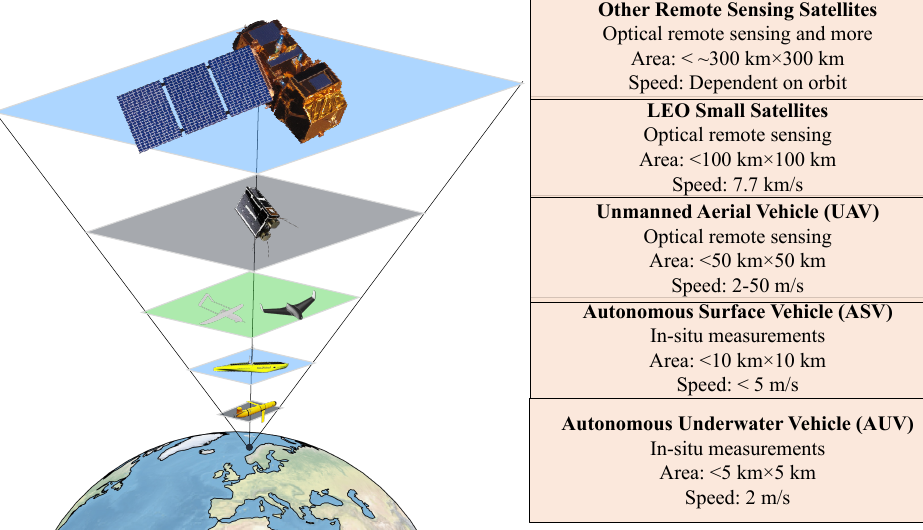
Figure 1. The observational pyramid with all the different autonomous data-collecting robotic agents developed at NTNU AMOS together with third-party satellite infrastructure. The right-hand side of the figure gives typical values for speeds, area coverage and data collection